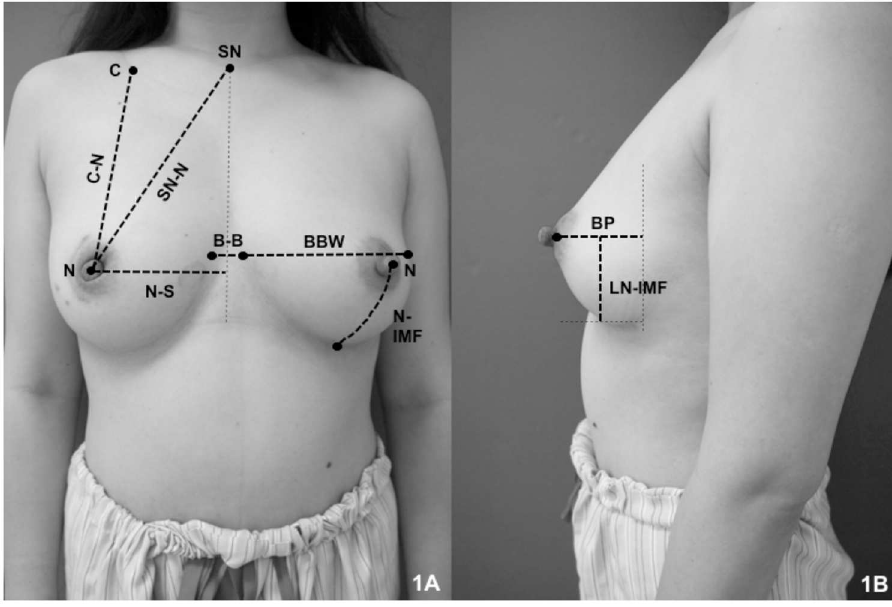
Fig 1. The methodology used to obtain breast measurements (front and lateral